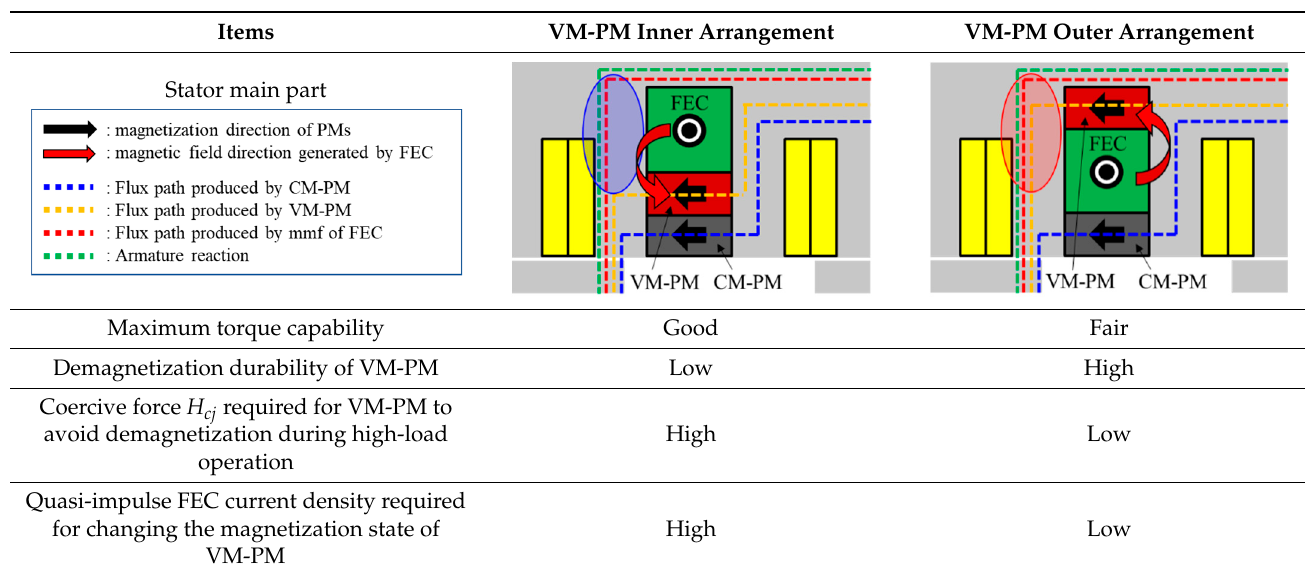
Table 4. Comparison of two types of VM-PM arrangements.